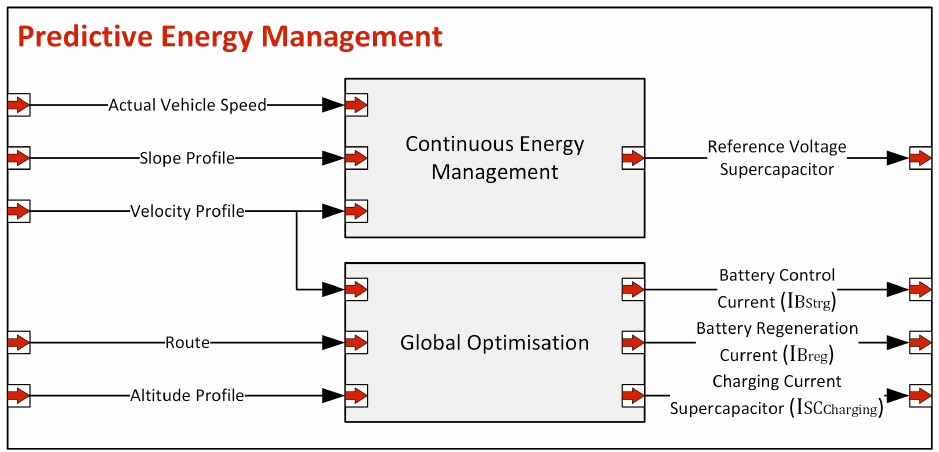
Figure 5. Predictive energy management for route-specific parameter optimisation of rule-based power